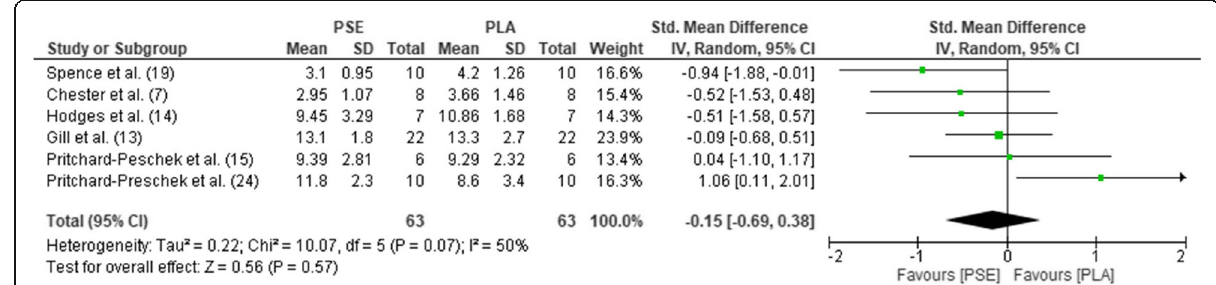
Fig. 6 Forest plot for effects of PSE on LAC with 95% confidence intervals.LAC: Blood lactate; PSE, pseudoephedrine; PLA, placebo; SD, standard deviation; Std., standardised; IV, instrumental variables; CI, confidence interval. Positive effect sizes represent an increase in LAC due to